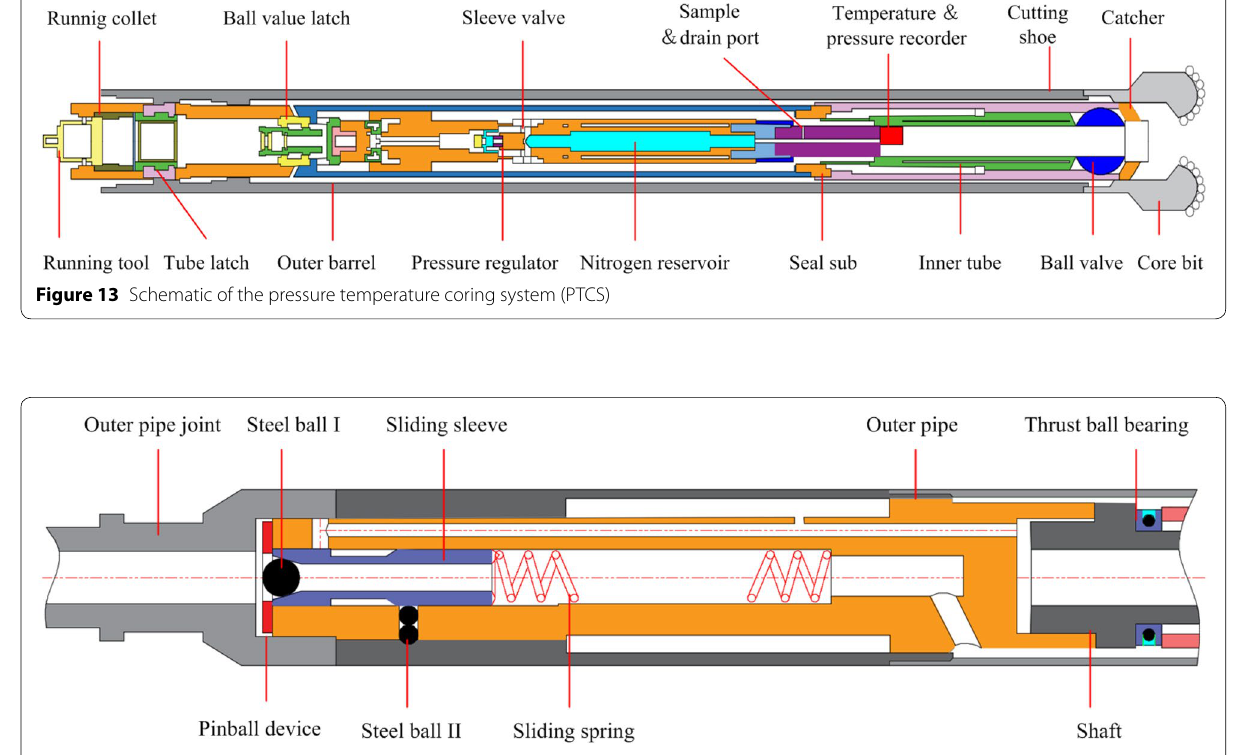
Figure 14 Schematic of the hole bottom freezing corer for gas hydrates